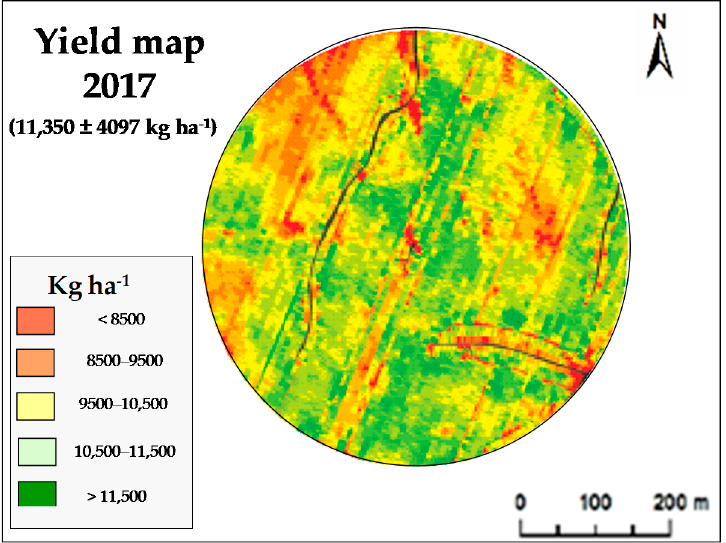
Figure 11. Corn yield map of the “Eucalyptus” field in October 2017.